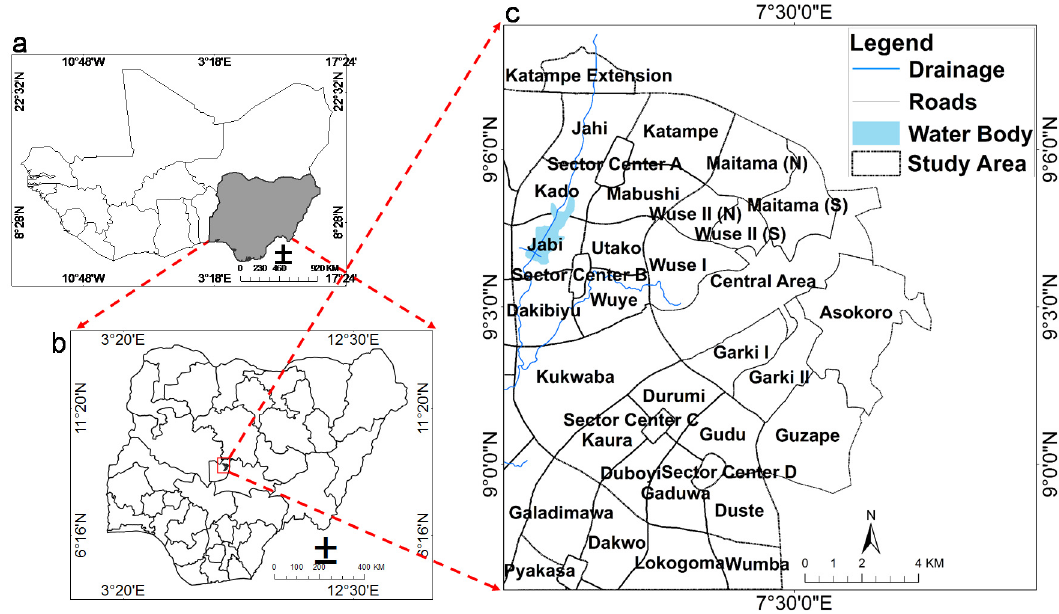
Figure 1. Location of study area. ( a ) West Africa inset Nigeria; ( b ) Nigeria inset Federal Capital City (FCT) and Abuja city in red rectangle and ( c ) Zoom of Abuja City showing major districts.